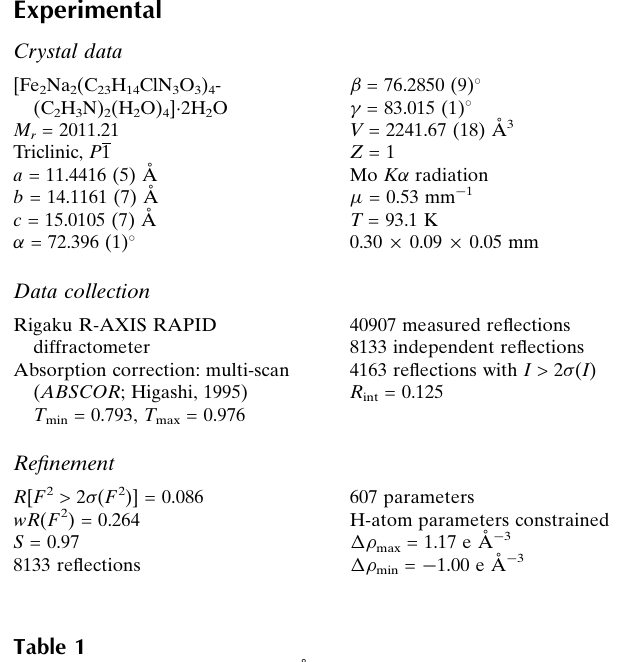
Selected geometric parameters (A˚ , (cid:2)